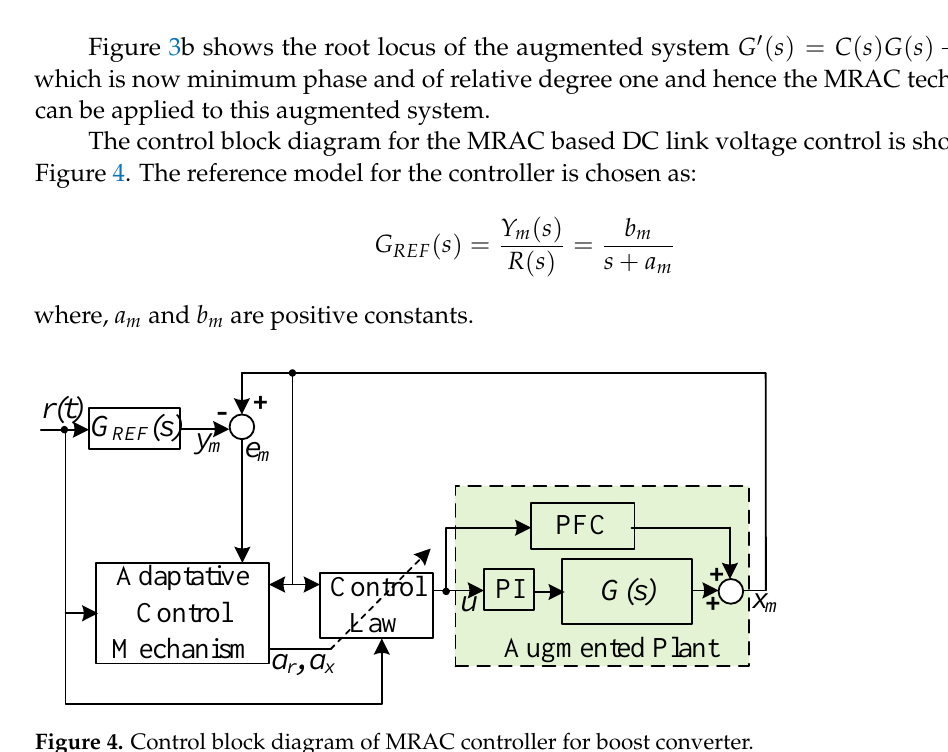
Figure 4. Control block diagram of MRAC controller for boost converter.